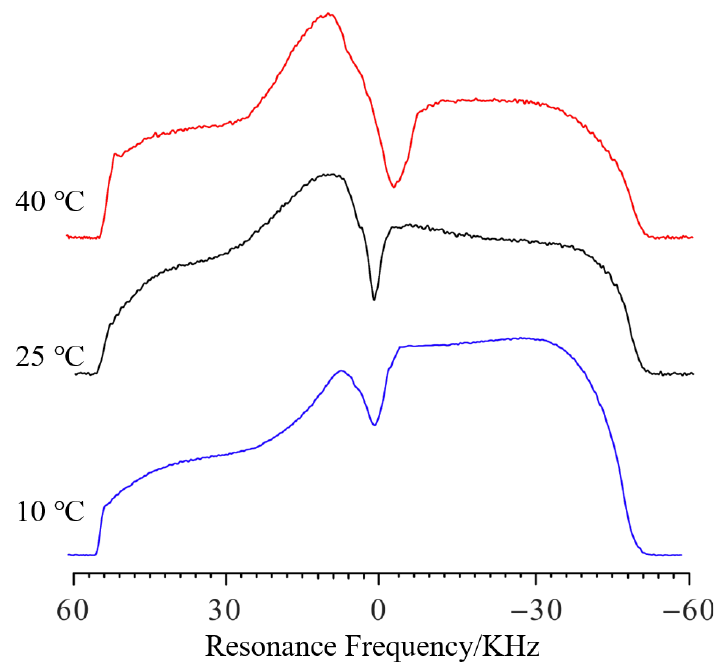
Figure 5. The NMR profile spectra of PMAB gels swelling at different temperatures but for the same amount of time (80 min). The blue line represents 10 °C, the black line represents 25 °C, and the red line represents 40 °C.